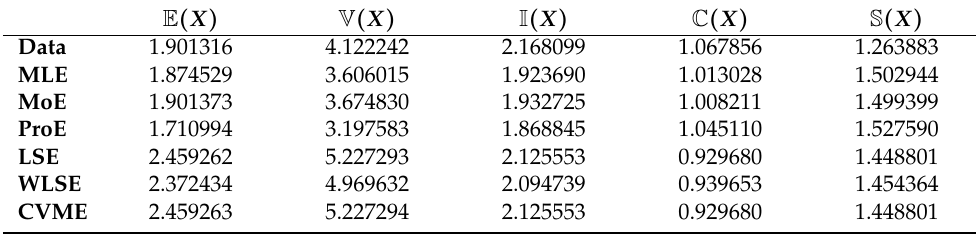
Table 14. Descriptive statistics for data set III.